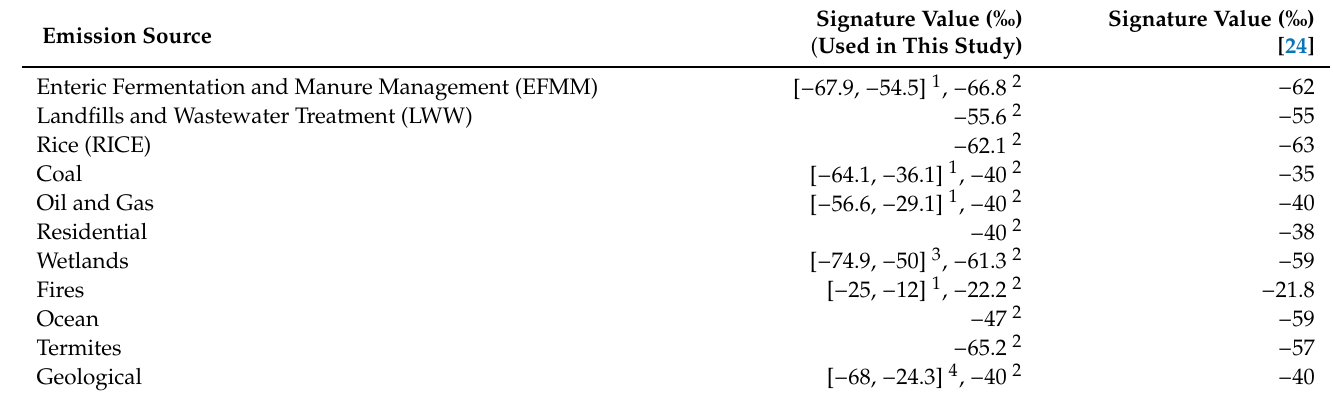
Table 1. Isotopic signatures used to convert CH 4 flux fields to 13 CH 4 fields. For values spatially varying globally, ranges of values are shown. Please see Supplementary Figure S3 for spatial distributions. Isotopic signatures from Monteil et al. [24] are also presented for